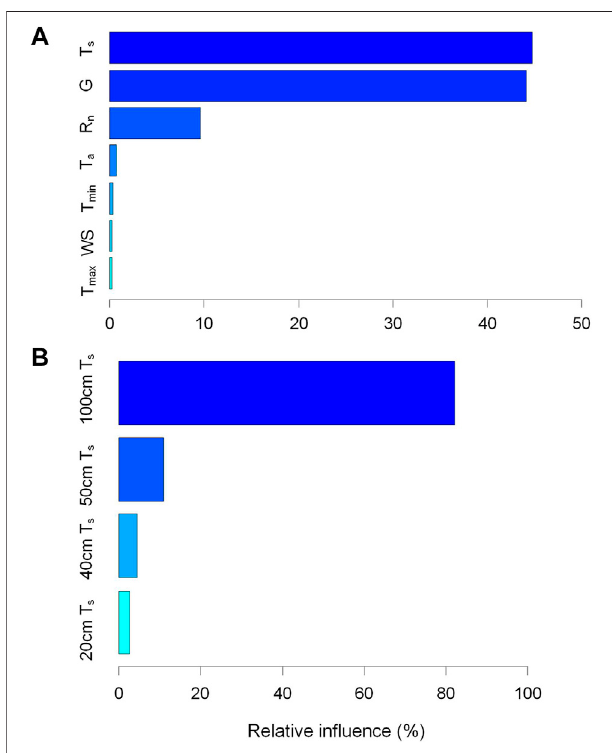
FIGURE 7 | The relative importance of environmental factors (A) and different soil temperatures (B) on seasonally frozen ground depth.